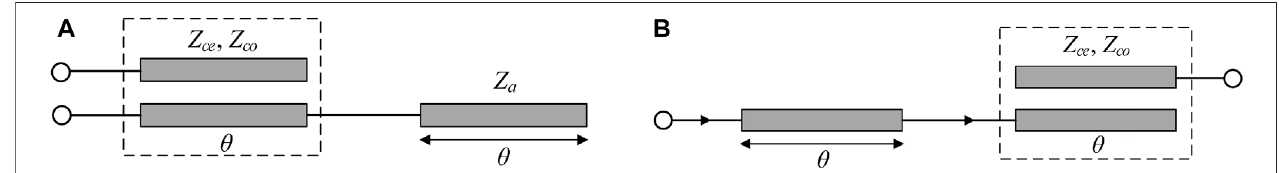
Frontiers in Physics |